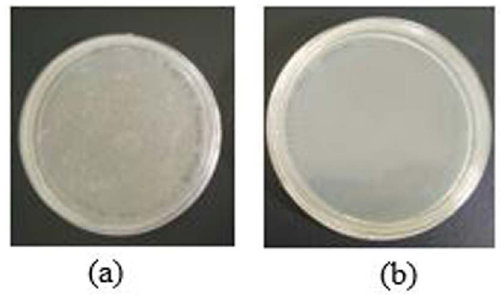
Fig. 5. Inhibition zones against Escherichia